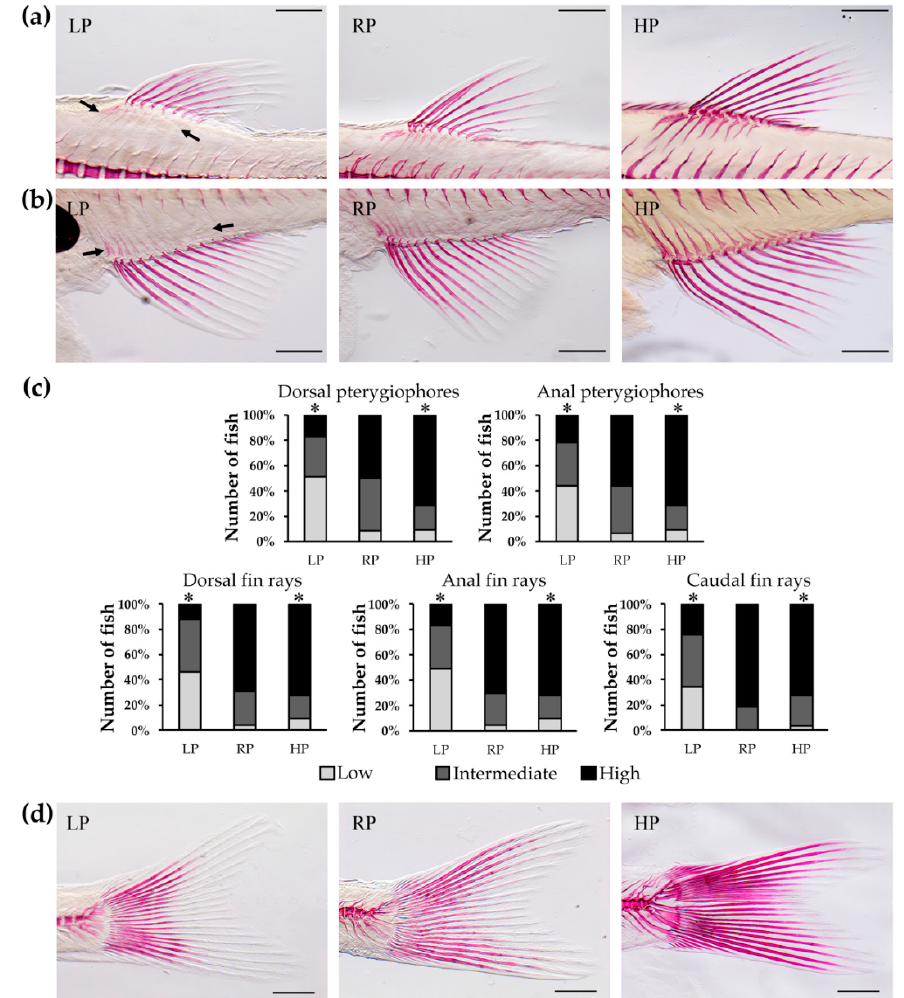
RP and HP animals. LP individuals present also a thin osteoid layer in the outer part of the vertebral body (black arrowheads), completely absent in RP and HP animals. Scale bar: 100 μ m. ( e’ ) High magnification of endplates in panel e . Extended non-mineralised bone matrix (black arrows) is visible in the vertebral endplates of LP animals. RP and HP zebrafish present thin endplates with reduced osteoid (black arrows). White arrowheads indicate intervertebral ligaments (see Figure 6a for details). Scale bar: 20 μ m. ( f ) Mineralisation of bone trabeculae (asterisks) is also affected by low P levels in the diet. Black arrows: endplates. Von Kossa/Van Gieson staining: mineralised bone: brown; non-mineralised collagen matrix/osteoid: red. Scale bar: 100 μ m.